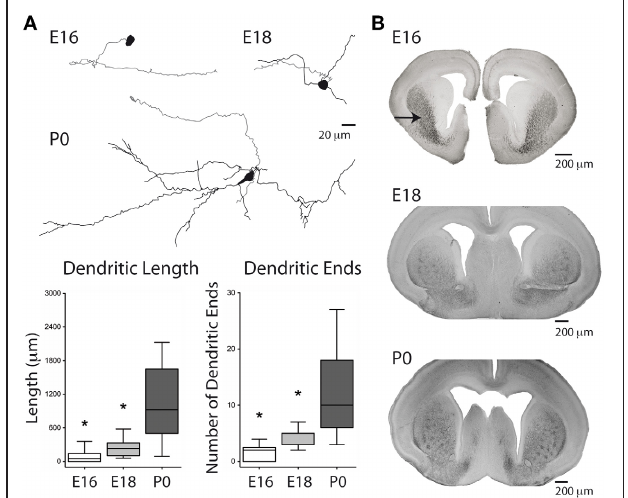
FIGURE 1 | Morphology of embryonic TH-positive midbrain neurons and distribution of TH-positive axons in the developing striatum. (A) (Top) Reconstructed neurobiotin-filled, GFP-positive, mDA neurons at the indicated ages. Somas and dendrites are in black, axons in gray. (Bottom) Box plots of dendritic length (left) and number of dendritic ends (right) as a function of age. ∗ Compared from E16 to E18 and from E18 to P0, Mann–Whitney test. (B) TH-positive axons (black staining) in the developing striatum (arrow) at the indicated ages.